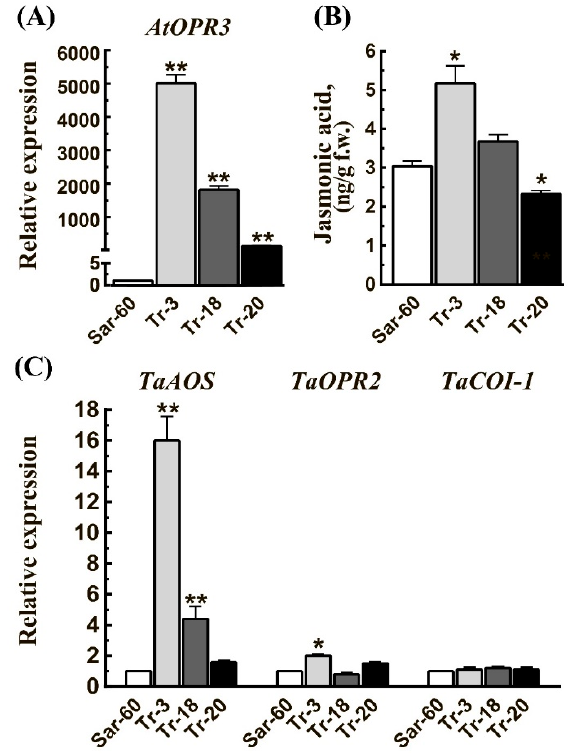
Figure 2. Gene expression analysis and JA levels in transgenic plants. The relative expression of AtOPR3 ( A ), and endogenous wheat jasmonate biosynthesis and signaling pathways genes TaAOS , TaOPR2 , and TaCOI-1 ( C ). Total RNA was extracted from leaves (the second leaf of T3 plants at four leaves stage) and subjected to real-time quantitative RT-PCR analysis. The transcript levels of each gene were normalized to TaWIN1 and TaUbi , as measured in the same samples. Data are means of four biological replicates represented by 6–8 leaves ± SE. ( B ) JA levels in second leaves of T3 plants collected at the four-leaf stage. Stars above the graphs indicate statistically significant differences (* p ≤ 0.05, ** p ≤ 0.001).